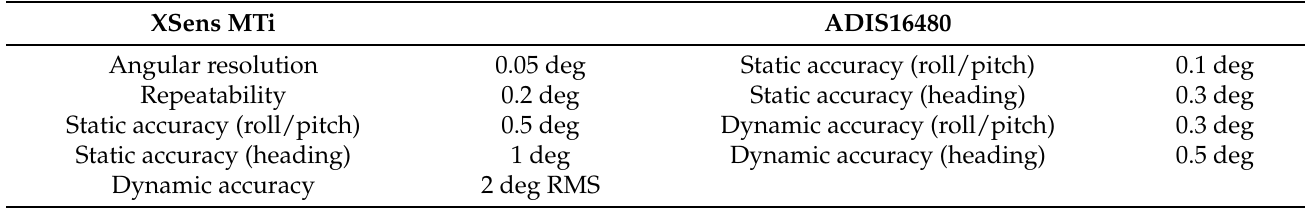
Table 1. Sparus AUV AHRS